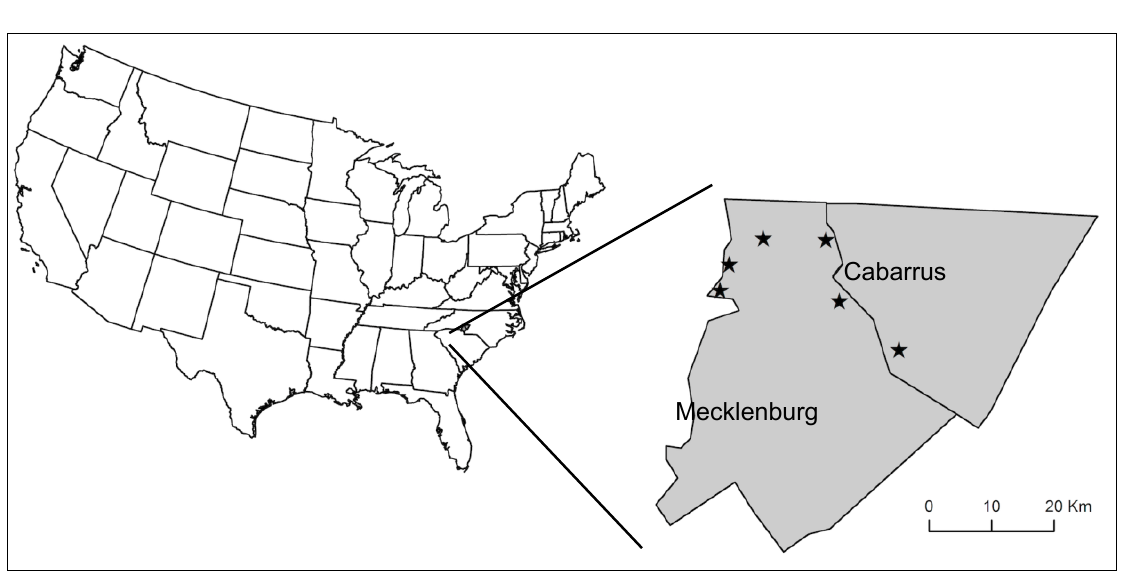
Figure 1. Map of study sites across the greater Charlotte area (Mecklenburg and Cabarrus counties) of North Carolina, USA. Inset map of the United States depicts location of counties in North